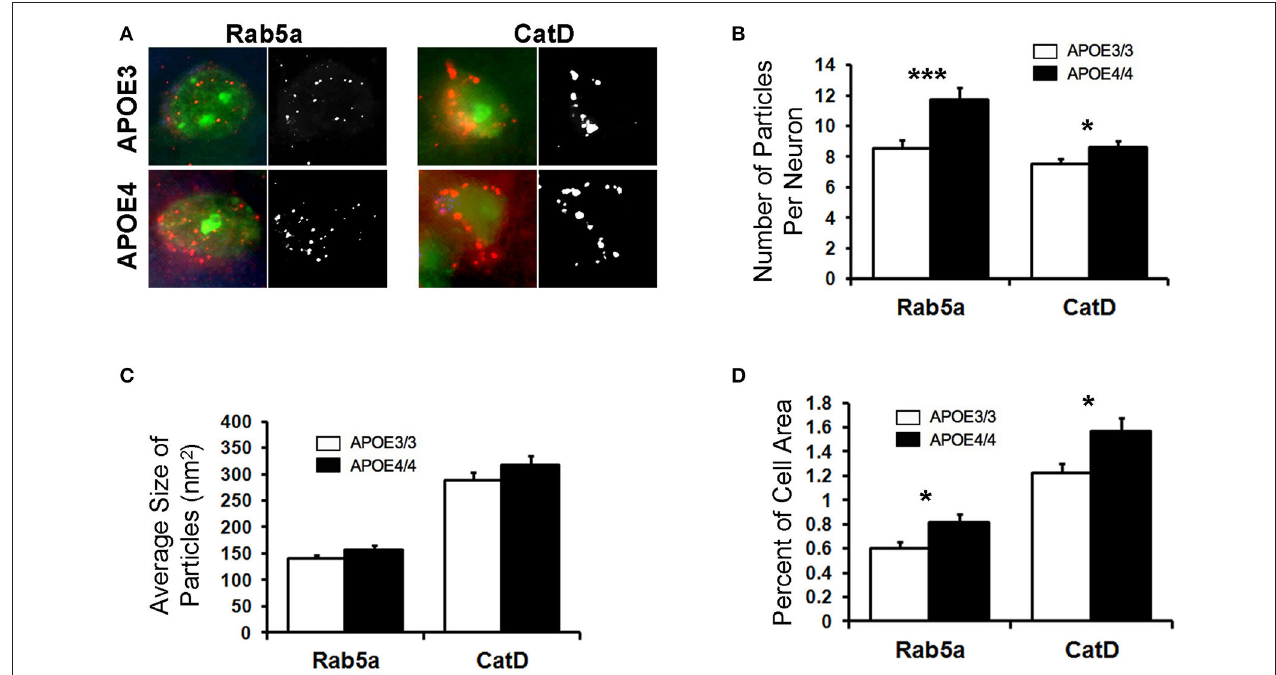
FIGURE 4 | The number and area fraction of Rab5a- and CatD-immunoreactive compartments are increased in the EC of aged APOE4/4 vs. APOE3/3 mice. Rab5a-immunoreactive early endosomes and CatD-immunoreactive lysosomes were quantified in the entorhinal cortex of 18 month-old APOE3/3 and APOE4/4 mice. (A) Representative images showing Rab5a and CatD immunolabeling (red), co-stained with Nissl (green). Black and white images were generated in ImageJ and used for quantification. (B–D) Quantification of average Rab5a- and CatD-positive compartment number (B), size (C) , and area fraction (D) in APOE4/4 vs. APOE3/3 mice. (* p < 0.05; *** p <